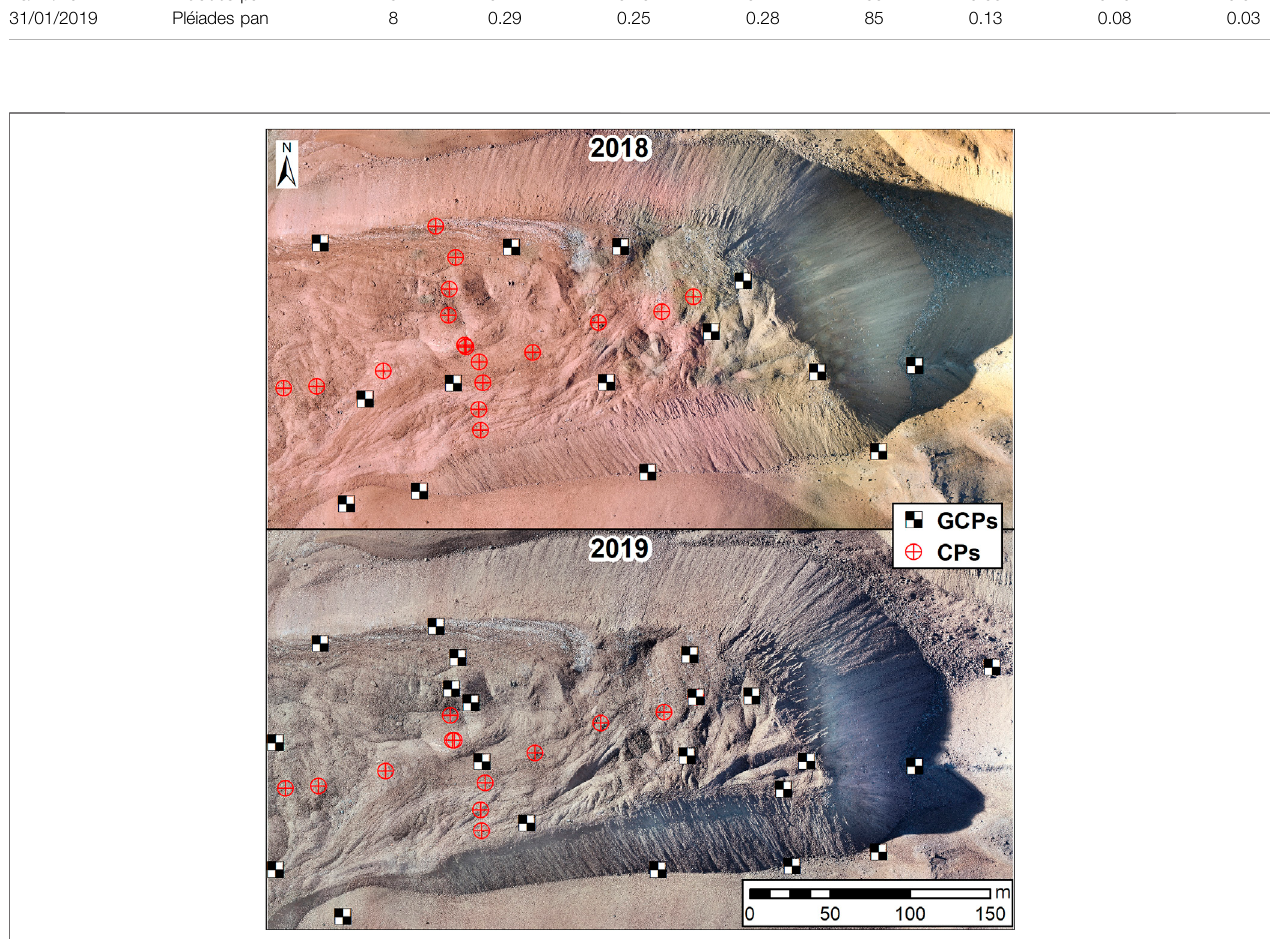
FIGURE 3 | Distribution of GCPs and CPs used during the 2018 and 2019 UAV surveys. The background images correspond to the UAV-derived orthomosaics from 2018 to 2019, respectively.